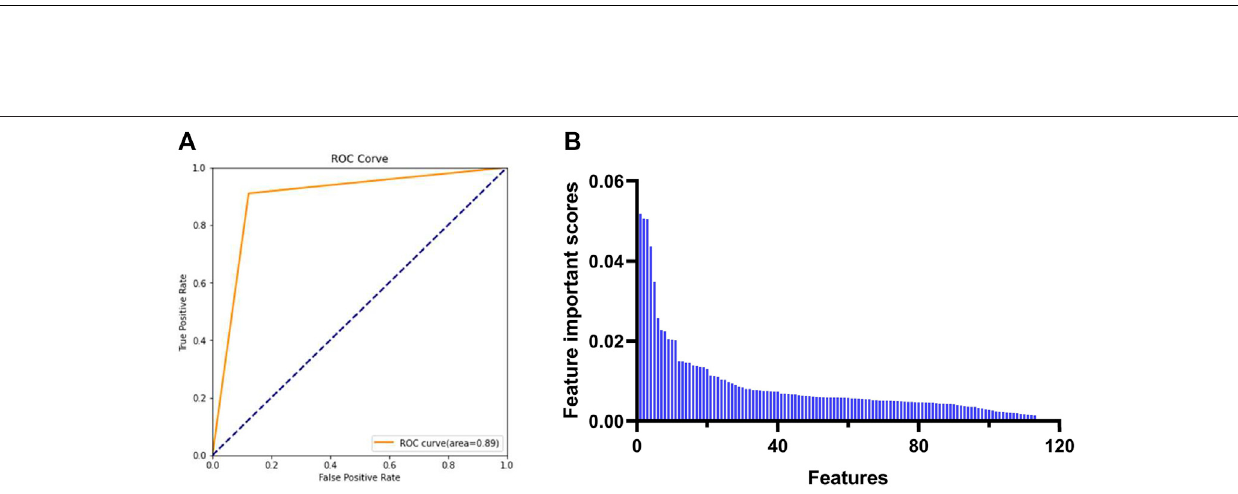
Frontiers in Pharmacology |